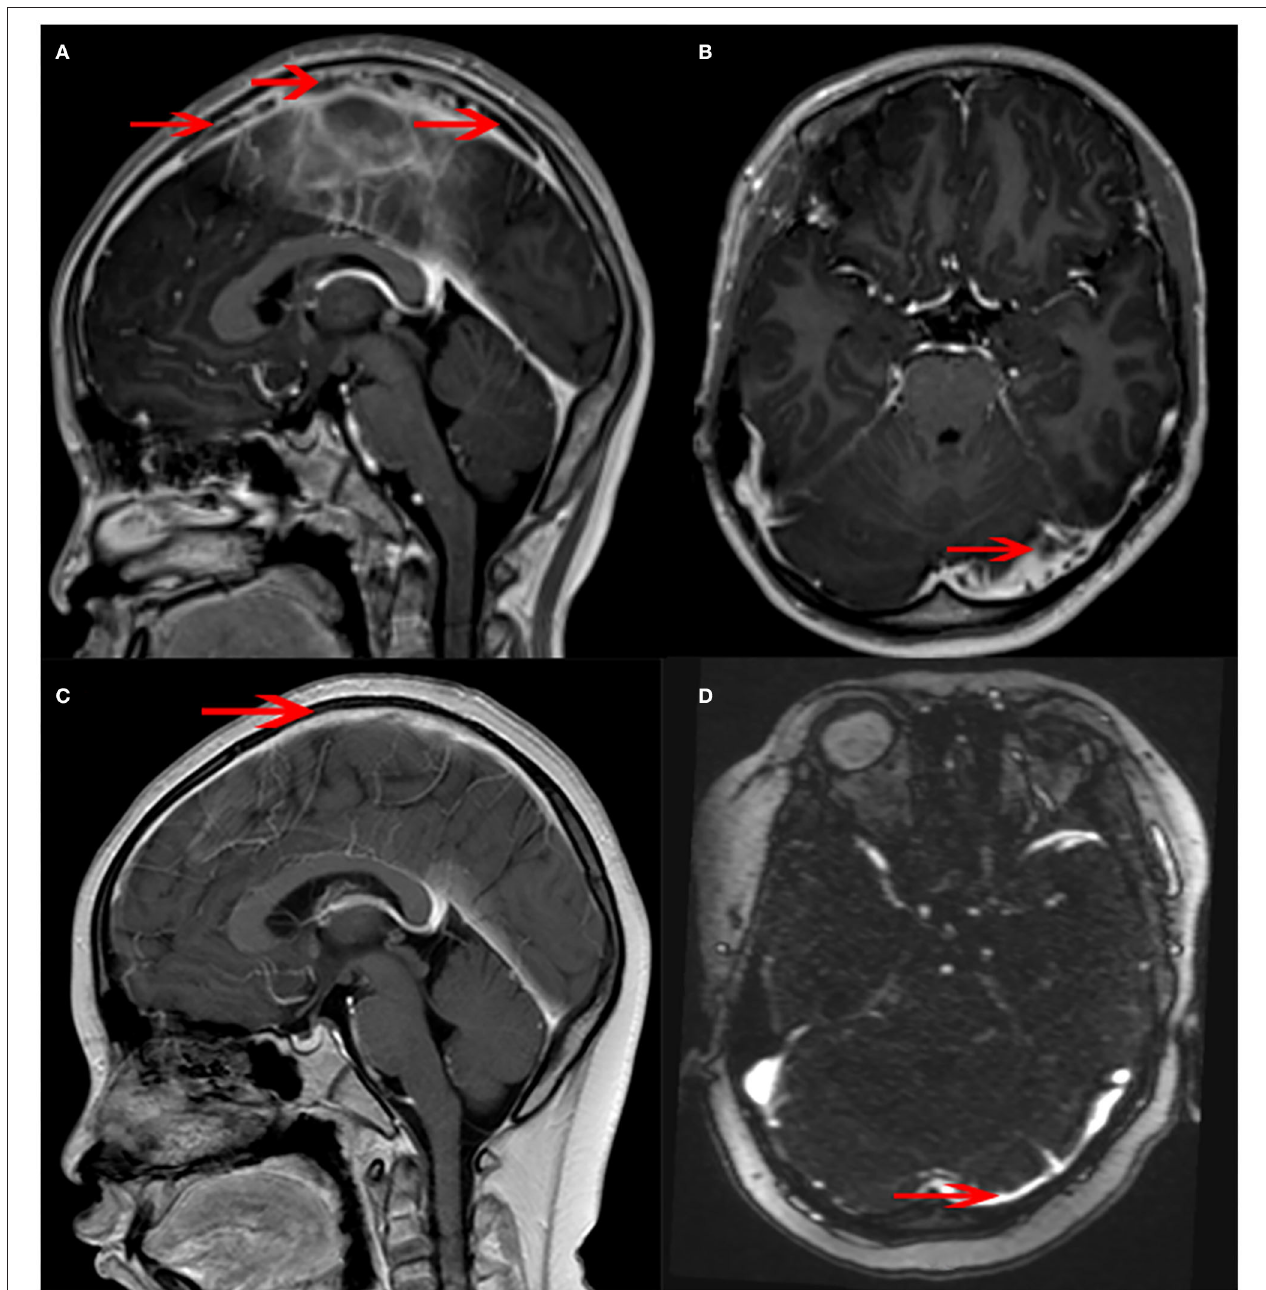
FIGURE 4 | Magnetic resonance venography (MRV) changes in the patient. (A) There were many banded filling defects in the superior sagittal sinus (arrow). (B) A few filling defects were seen in the left transverse sinus (arrow). (C) The superior sagittal sinus was slightly narrowed, and the margin was rough (arrow). No obvious intracranial venous thrombosis was observed. (D) The left transverse sinus was slightly thin (arrow).